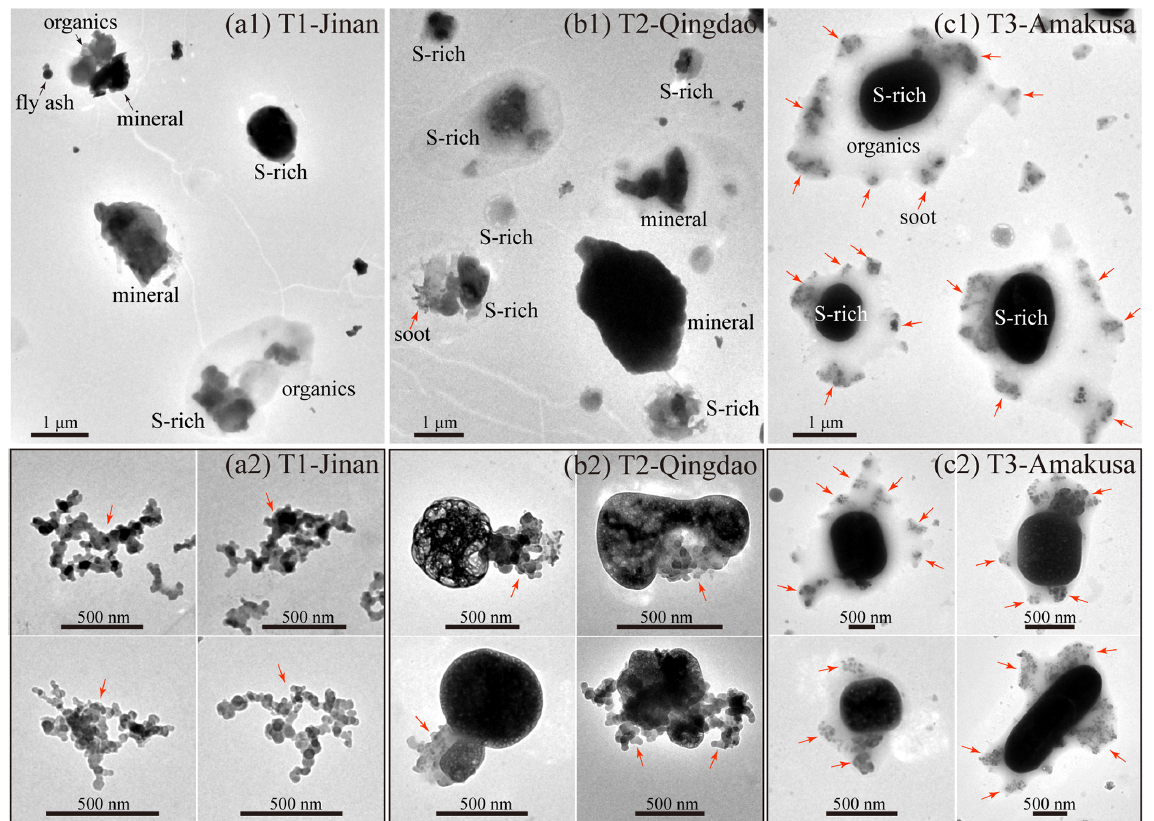
Figure 7. (a1–c1) Low-magnification TEM images at T1, T2, and T3. (a2–c2) TEM images of soot-dominated particles at T1, T2, and T3.